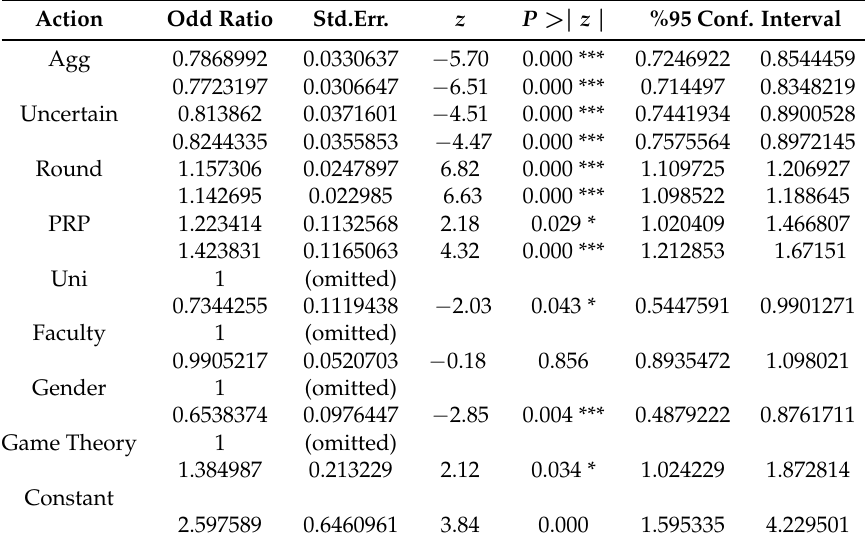
Table 4. Entrants-Panel Logistic Regression